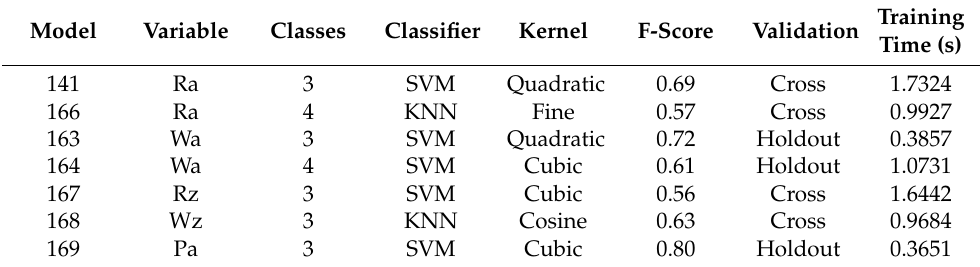
Table 4. Results of the models developed. Intervals for the arithmetic roughness, Ra, are: 3 classes— class A [0.495, 0.799] µm; class B (0.799, 1.11] µm; class C (1.11, 2.81] µm; 4 classes—class A [0.407,